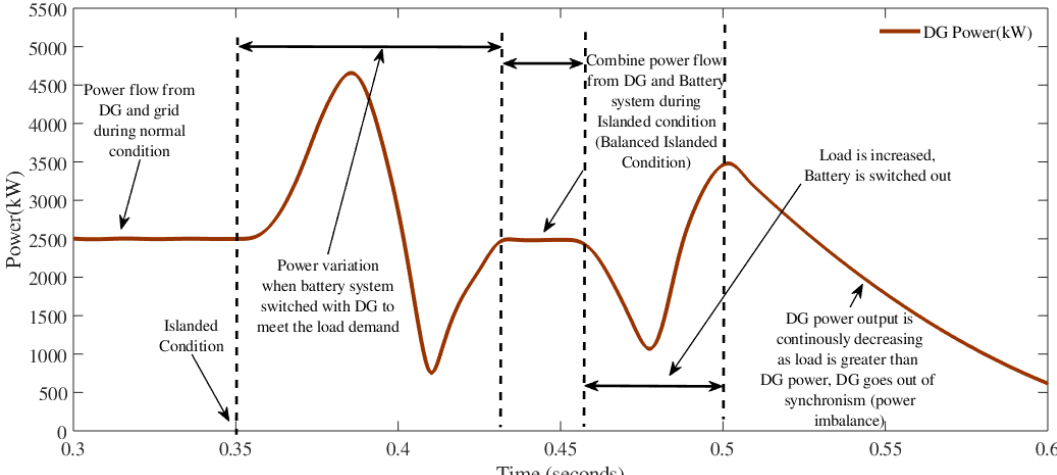
Figure 15. DG output under different system conditions. Until 0.35 s, a load of 5000 kW is shared equally among the mains and DG. At 0.35, the mains are tripped, and the system enters the islanding mode with the load greater than the DG, and thus, the ESS is switched in, to tackle the energy difference. At 0.45 s, the load is further increased, which causes the power imbalance with the DG’s output constantly decreasing, which represents its being out of synchronism.